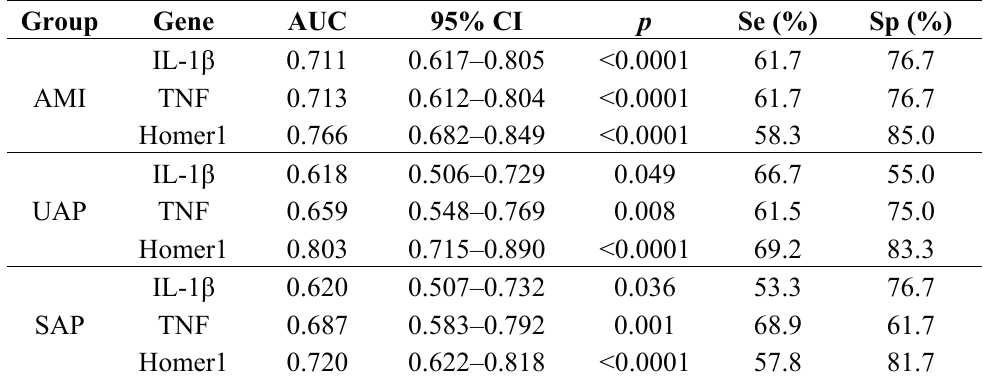
Table 3. Comparisons of the AUC (95% CI) of the expression of Homer1, IL-1 β , and TNF- α for AMI, UAP, and SAP